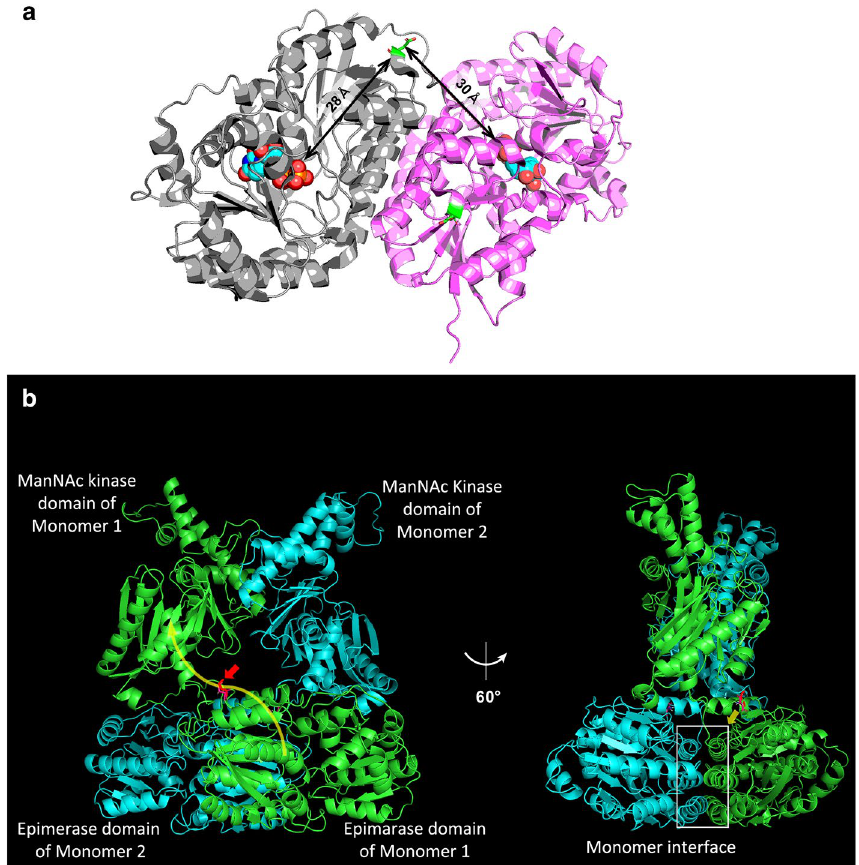
Figure 4. Location of aspartic acid 176 in a GNE protein structural model. ( a ) Structure of the epimerase domain of GNE according to Protein Data Bank (4ZHT). Aspartic acid 176 is located outside of the catalytic site (at 28 Å within the same domain and 30 Å from the other monomer). ( b ) Full-length GNE protein structure predicted using AlphaFold2. Left: Illustration of a GNE dimer consisting of monomer 1 (light blue) and monomer 2 (light green). Aspartic acid 176 (red) is located on the surface of the epimerase domain, which may be involved in intramolecular ManNAc transfer (yellow arrow in monomer 1). Side view of the GNE complex rotated by 60°. Aspartic acid 176 is located near the dimer-dimer interface but does not appear to be directly involved in the interaction between the two